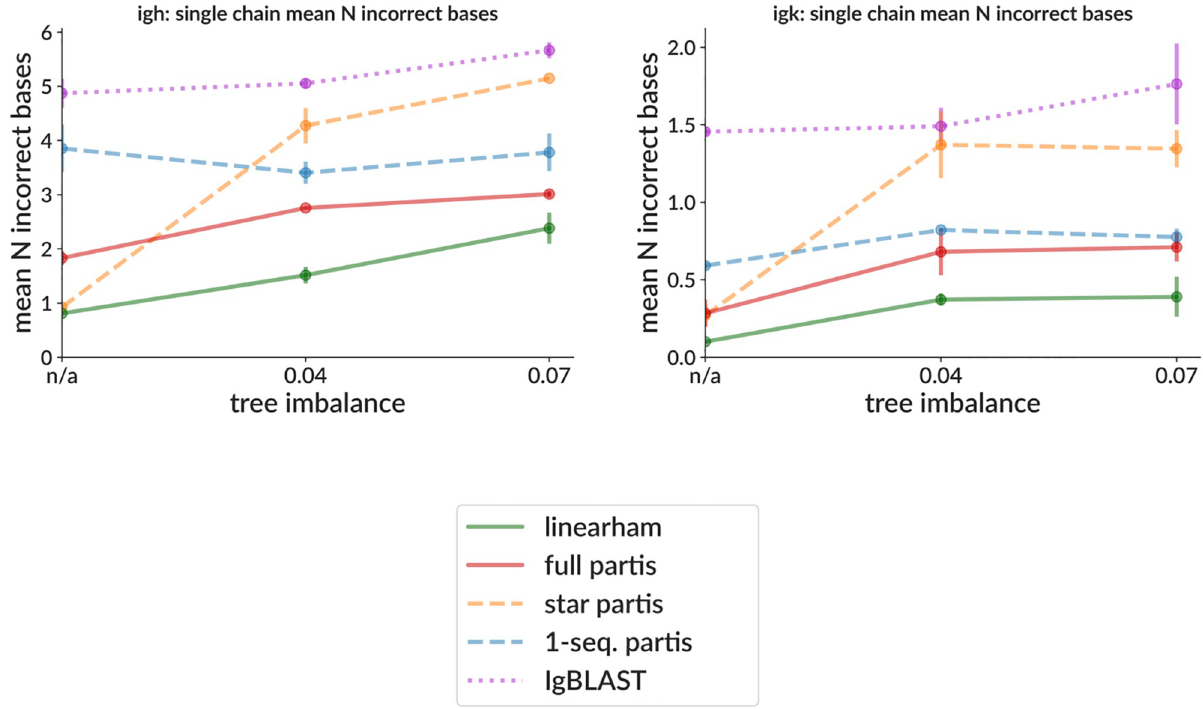
Fig 9. Naive sequence inference accuracy on simulation as a function of tree imbalance. Accuracy is measured as the Hamming distance separating the true and inferred naive sequences. Tree imbalance (the standard deviation of root-to-tip distances) is shown for samples with precisely zero imbalance (“n/a”, since it uses a different simulation framework), and samples generated from the imbalanced trees from [47]. Several partis versions are shown: “1-seq.” uses only information from each single sequence for its annotation (rather than from all family members); “star” approximates each family as a star tree (as in partis versions before May 2021 https://bit.ly/3KIjFiF); “full” is the current default, including subcluster annotation, which improves on the star tree assumption by iteratively annotating small subtrees. Each point is the mean ( ± standard error) over two samples with 15% mean nucleotide SHM, each consisting of 50 simulated rearrangement events with sizes of around 50 (drawn from geometric for zero imbalance; otherwise taken from the trees from [47]).